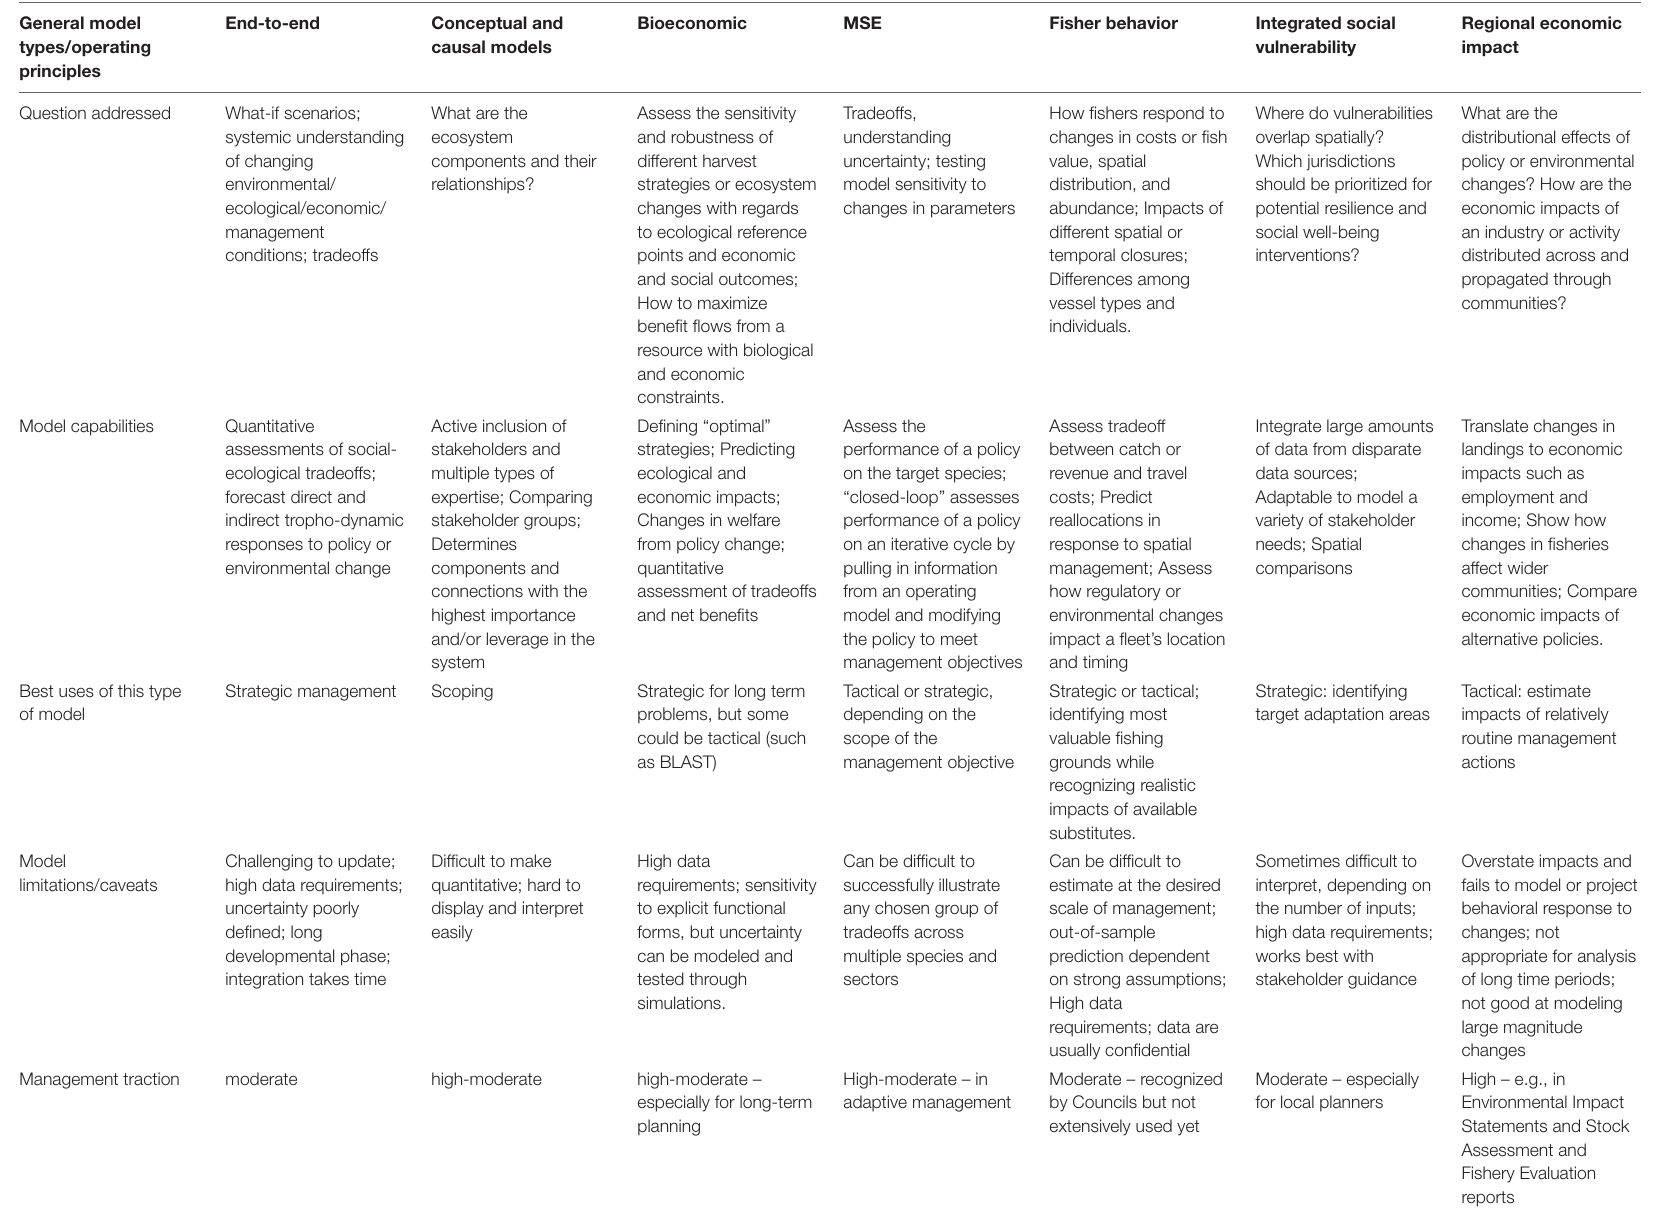
TABLE 1 | General types of coupled SES